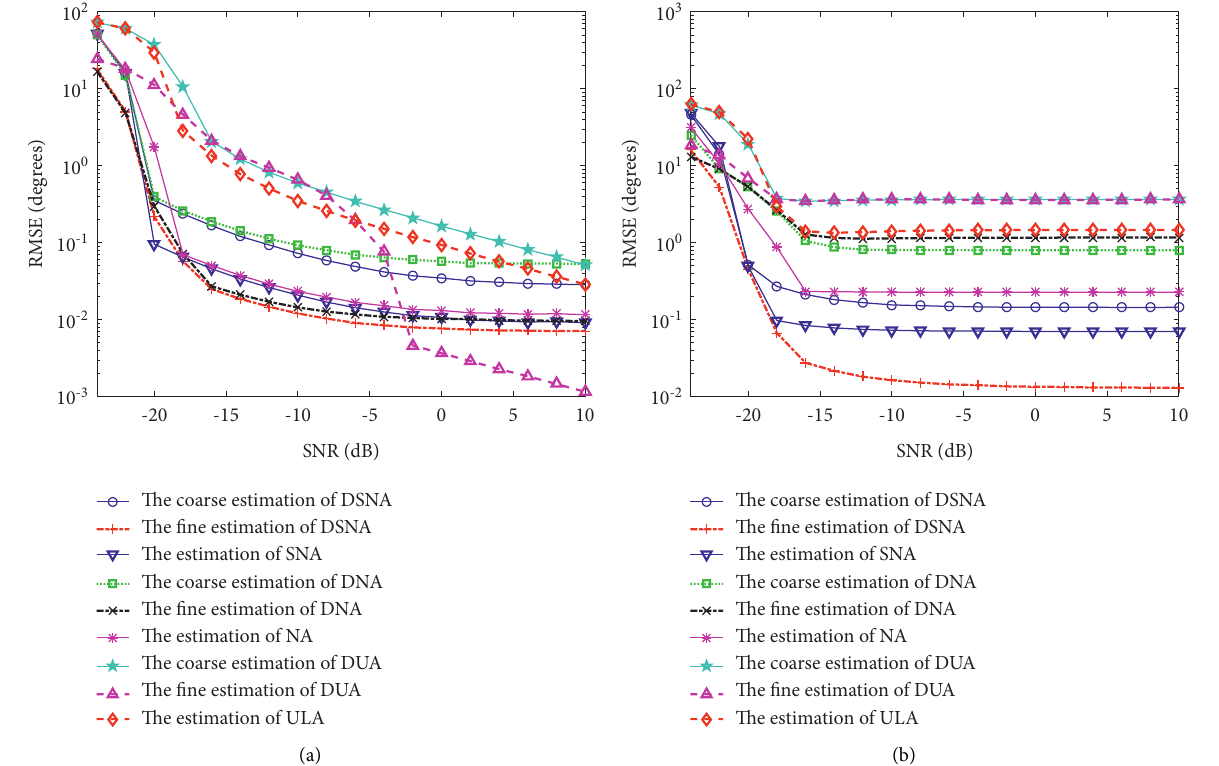
Figure 9: Multiple-source signals and d � λ /6; the baseline length is 45 times the wavelength. (a) Not considering mutual coupling between the array antennas. (b) Considering mutual coupling between the array